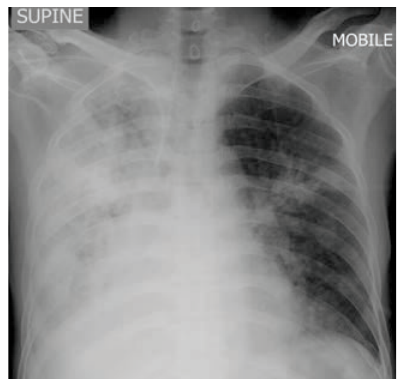
arrowheads.Fig. region.Fig. 1. Chest radiograph demonstrating cavitary pulmonary tuberculosis with marked destruction the hypervascular of the right Fig. 3. (a) Axial contrast enhanced CT demonstrates filling of the Rasmussen aneurysm (arrow). The hyperdense ovoid structure in the oesophagus is a medicine tablet; (b) coronal reformation illustration of the aneurysm (arrow); (c) pulmonary angiogram demonstrates a Rasmussen aneurysm (arrow) in the right upper lobe posterior segment pulmonary artery; (d) post-embolisation pulmonary angiogram with occlusion of the vascular pedicle and exclusion of the Rasmussen aneurysm. The coils are indicated by the